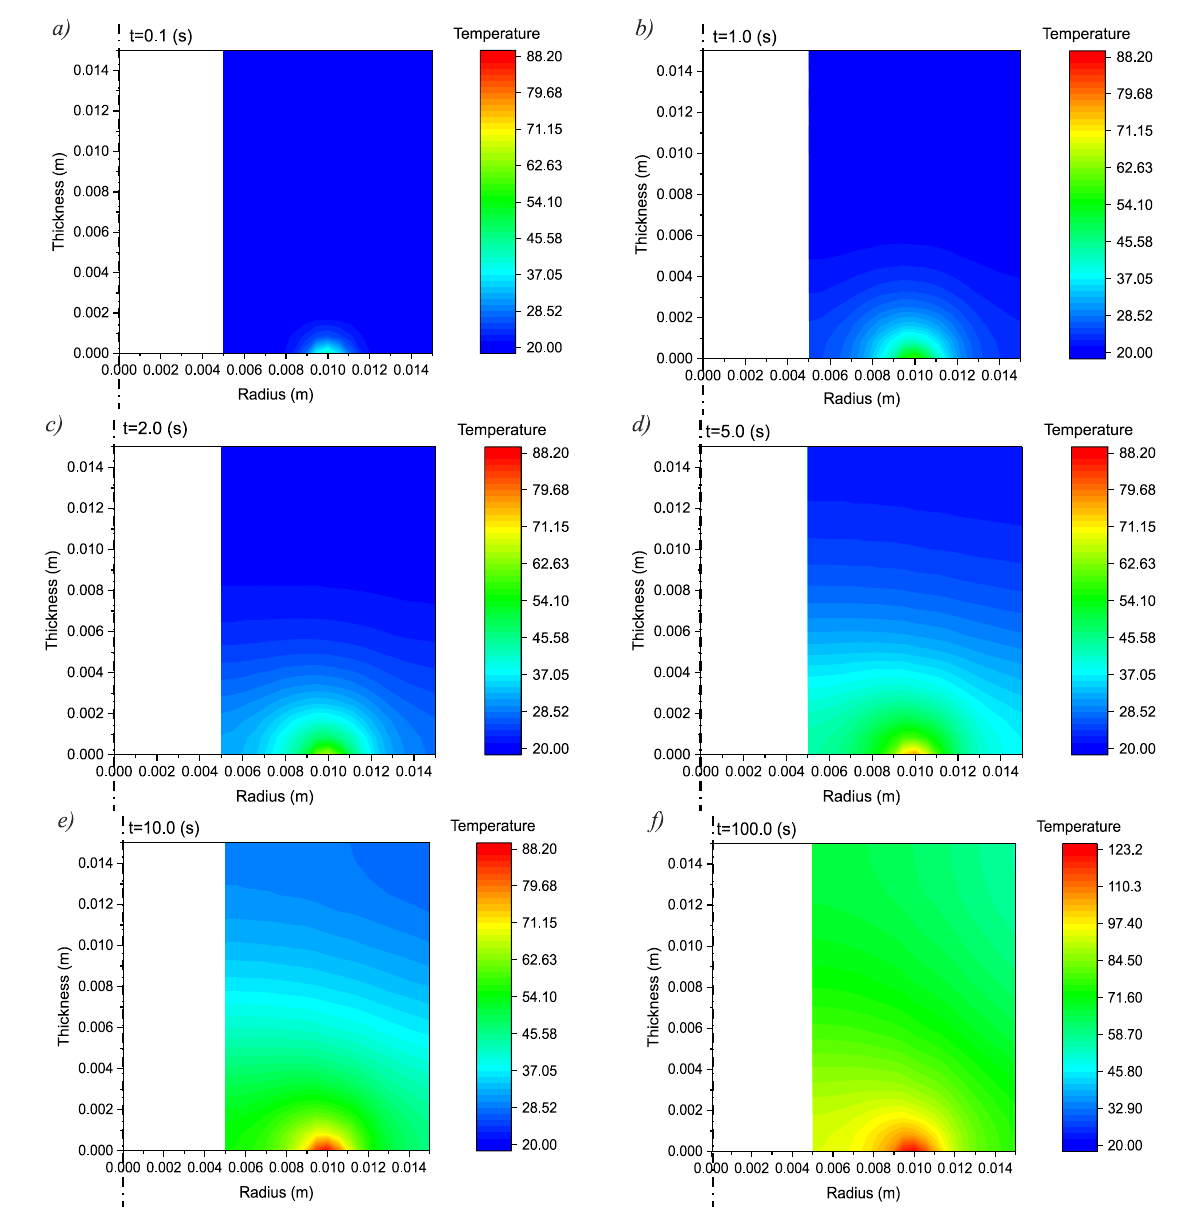
Fig. 3. The temperature distribution in the cross-section of the hollow cylinder for different t.